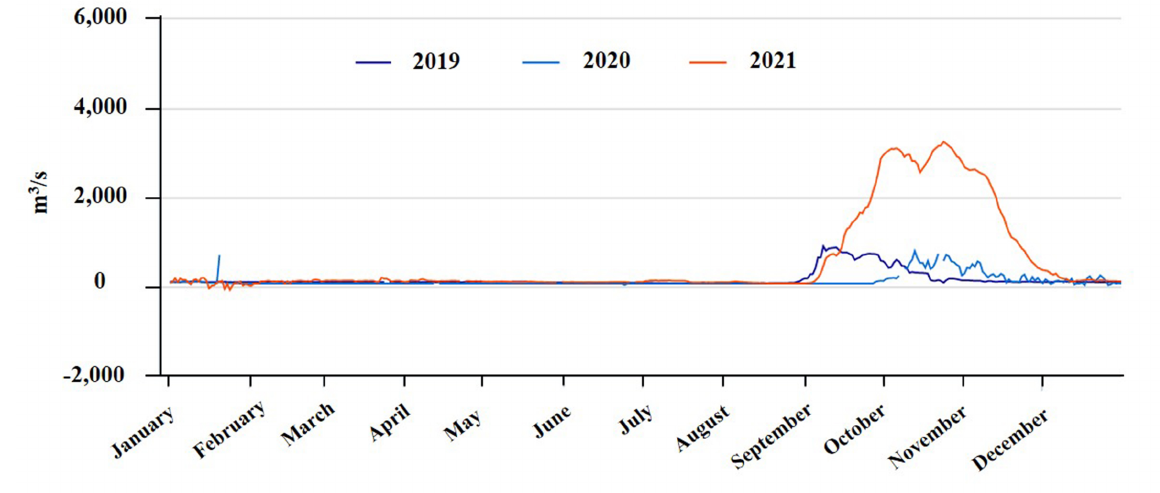
Fig. 2. Average monitored daily water flow rate at the Bang Sai station during 2019–2021. (Source: https://tiwrm.hii.or.th/thaiwater_l5/public/itc_water_graph/station_id=587)